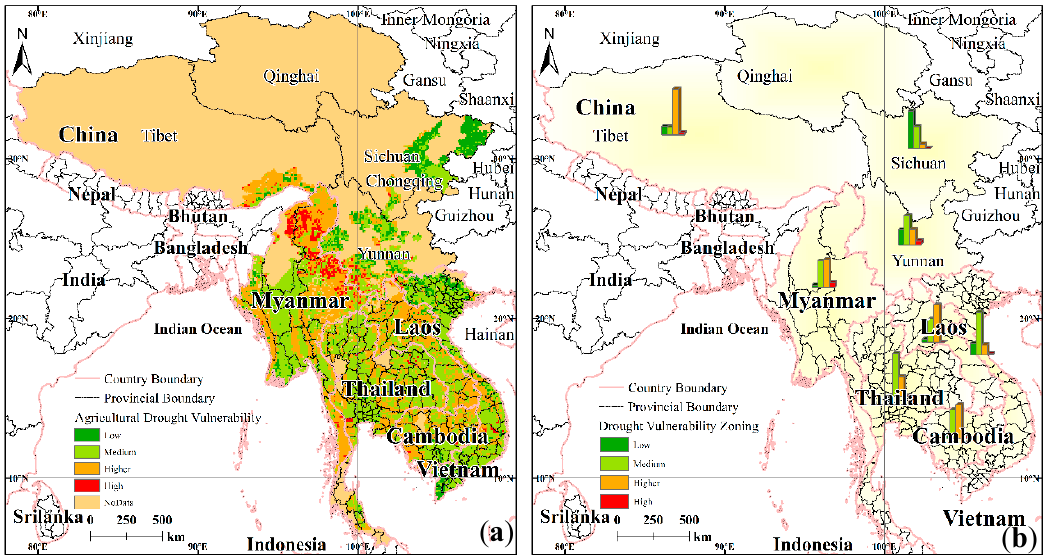
Figure 11. Spatial distribution ( a ) and regional differences ( b ) of drought vulnerability in the LMR.